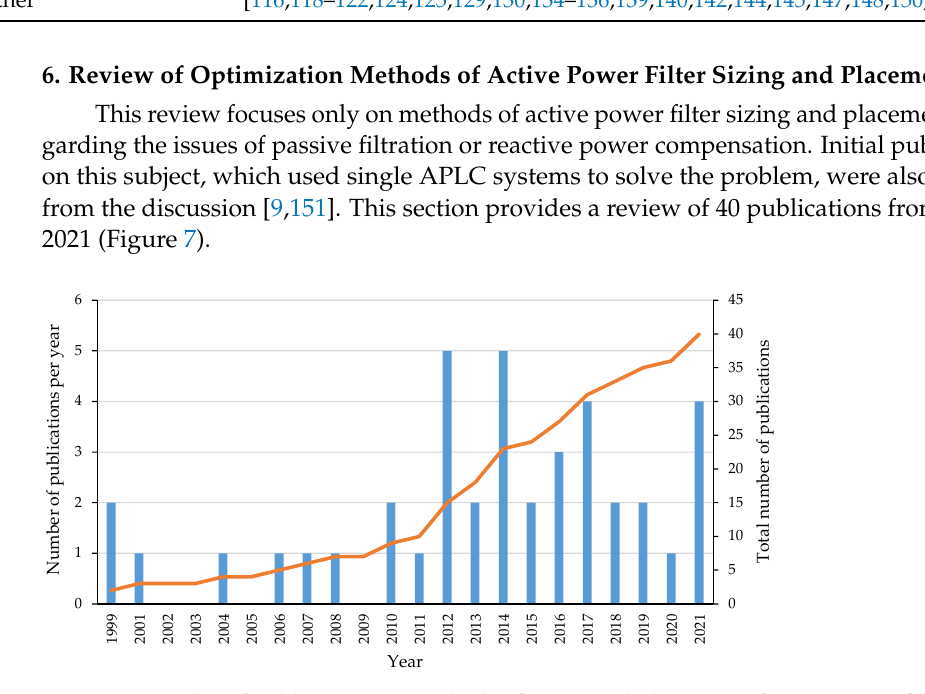
Figure 7. Number of publications on methods of sizing and placement of active power filters.